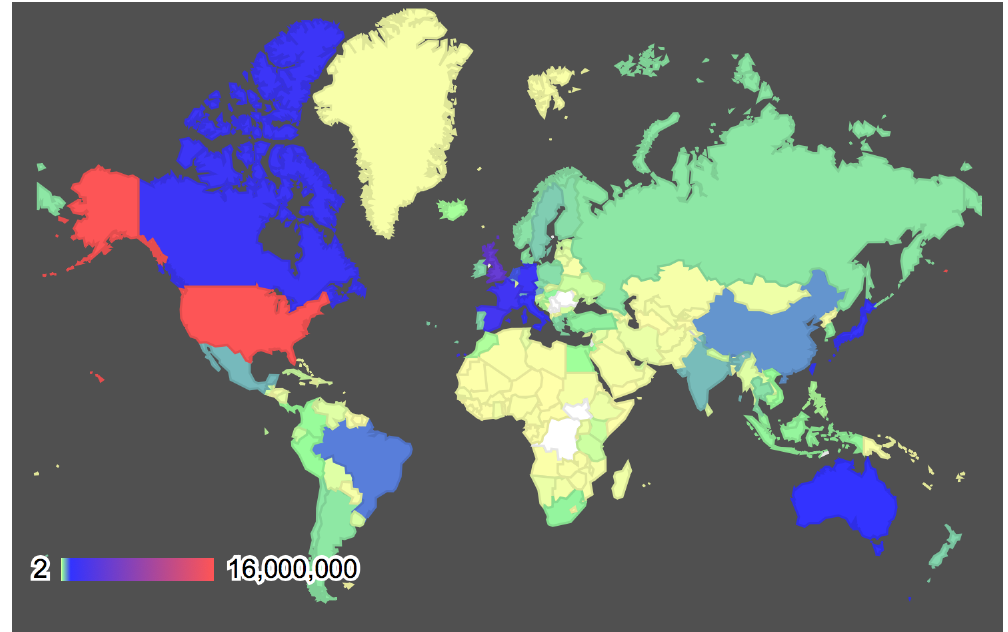
Figure 1. One million photo sample of the 48 million geo-tagged photos from the Yahoo Flickr Creative Commons 100M (YFCC100m) dataset plotted around the globe (image source: The Competence Center Multimedia Analysis and Data Mining (MADM) at the DFKI).